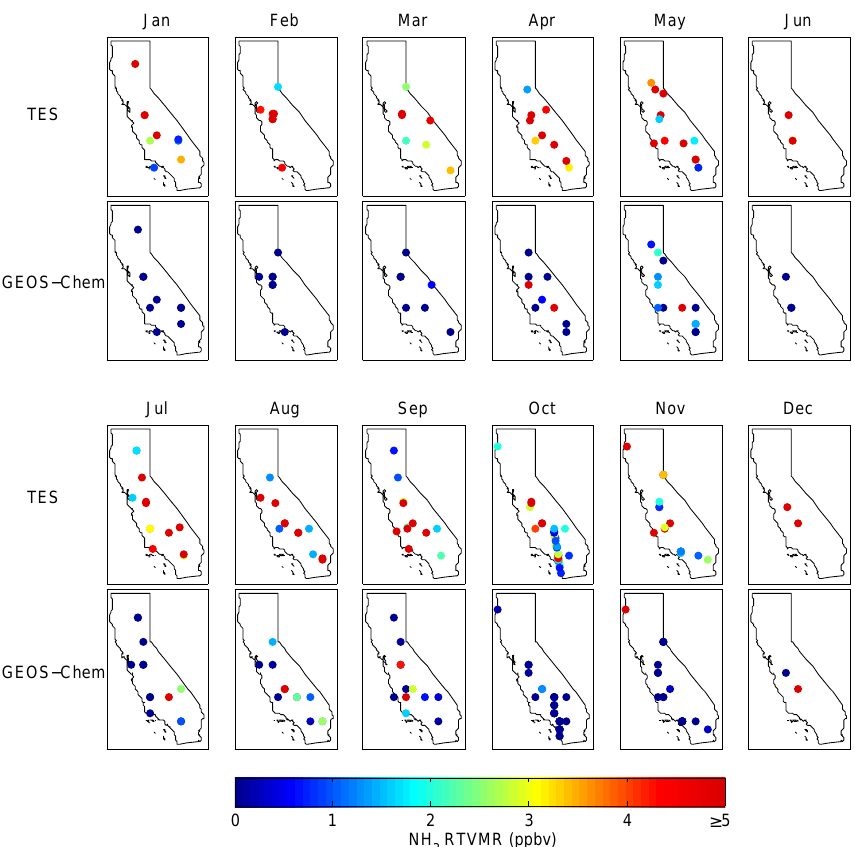
Fig. 14. Satellite-measured (TES) and predicted ammonia RVMR concentrations for 2009. Data points shown are individual measurements in each month; some data points overlap when there is more than one measurement at a location within a